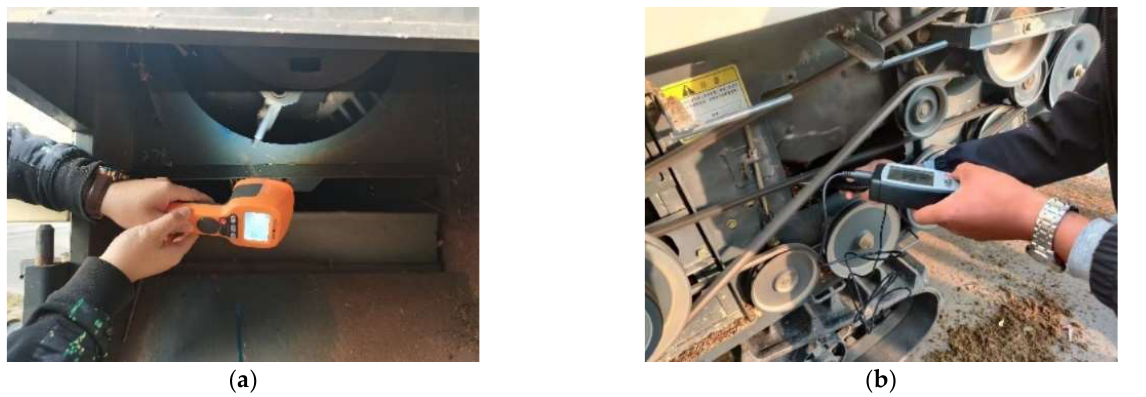
Figure 11. Determination of threshing drum speed and centrifugal fan airspeed on the prototype: ( a ) Threshing drum speed determination. ( b ) Centrifugal fan outlet air velocity determination.